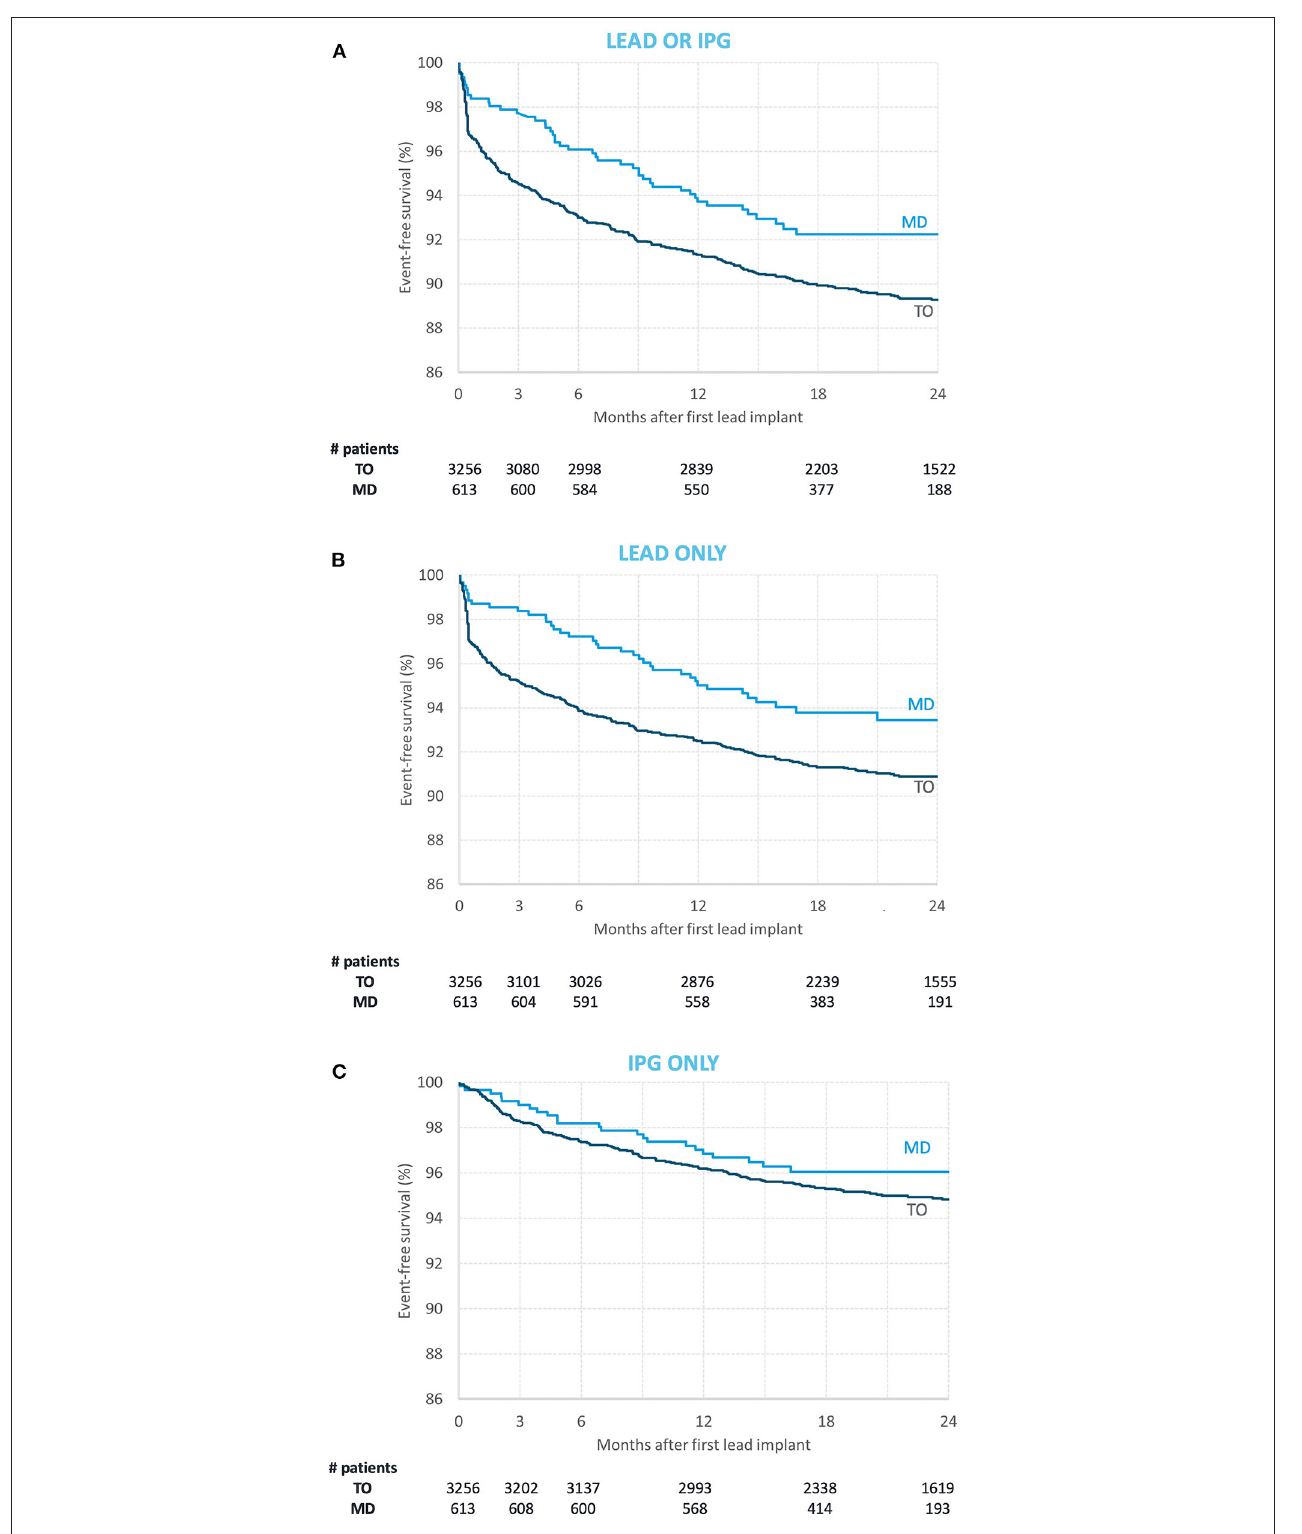
FIGURE 2 | Event-free survival curves for the modern directional (MD) subgroup (light blue) and the traditional omnidirectional (TO) subgroup [dark blue] with regards to (A) lead and implantable pulse generator (IPG) reoperations combined, (B) lead only reoperations, and (C) IPG only reoperations. The number of subjects in each subgroup at index implantation and at 3-, 6-, 12-, 18-, and 24-month follow-up are reported below each graph.